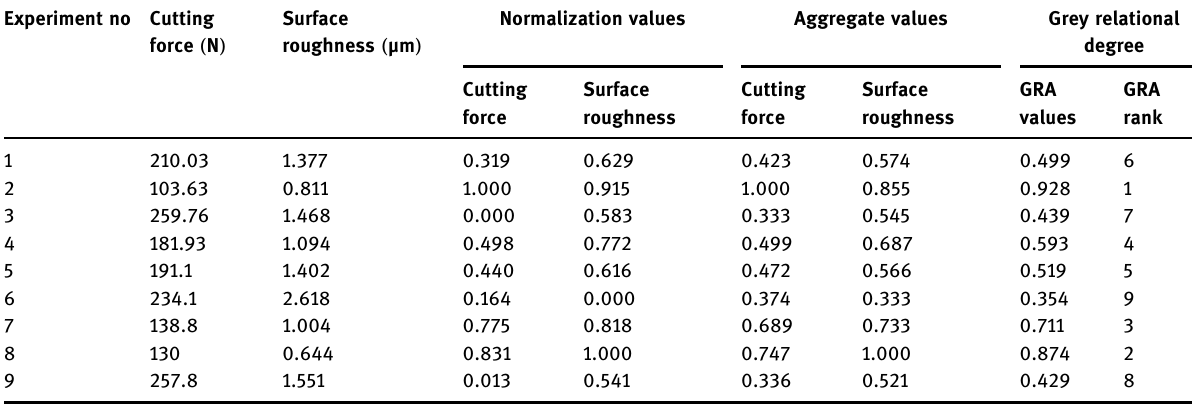
Table 5: Normalized data, delta values, and grey relational grade for wiper insert tool Experiment no Cutting